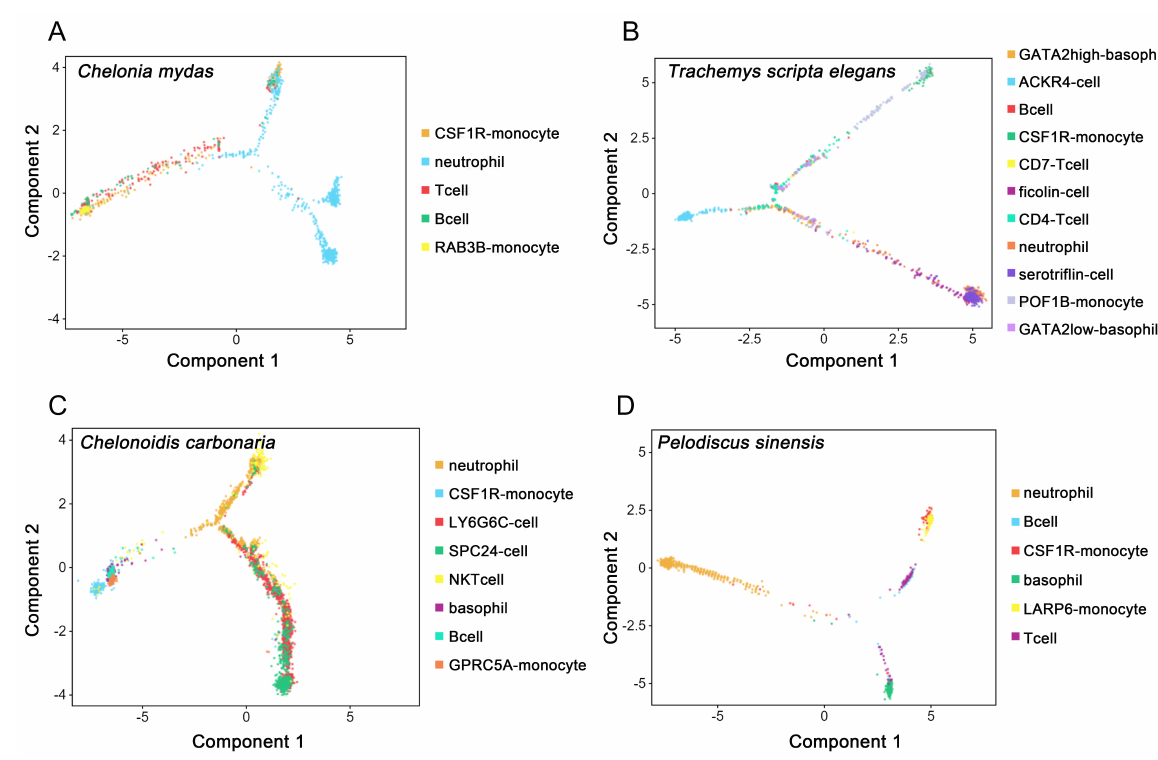
Figure 7. Differentiation trajectories of peripheral immune cells in testudines. ( A ) C. mydas ; ( B ) Trachemys scripta elegans ; ( C ) C. carbonaria ; and ( D ) P. sinensis